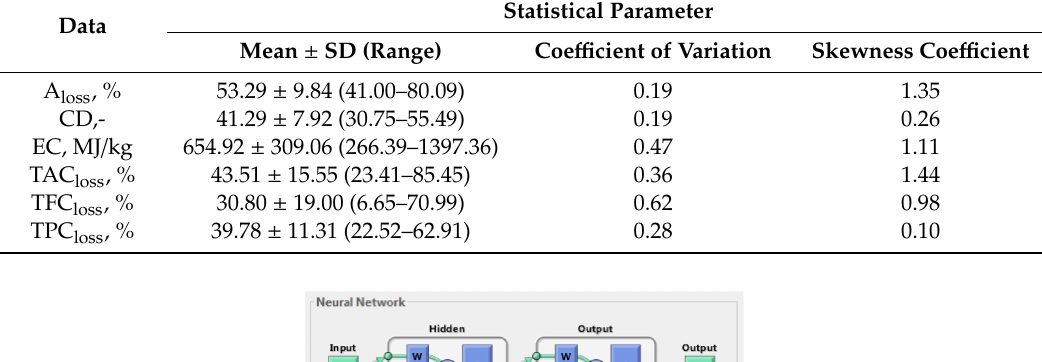
Table 1. The statistics of data.